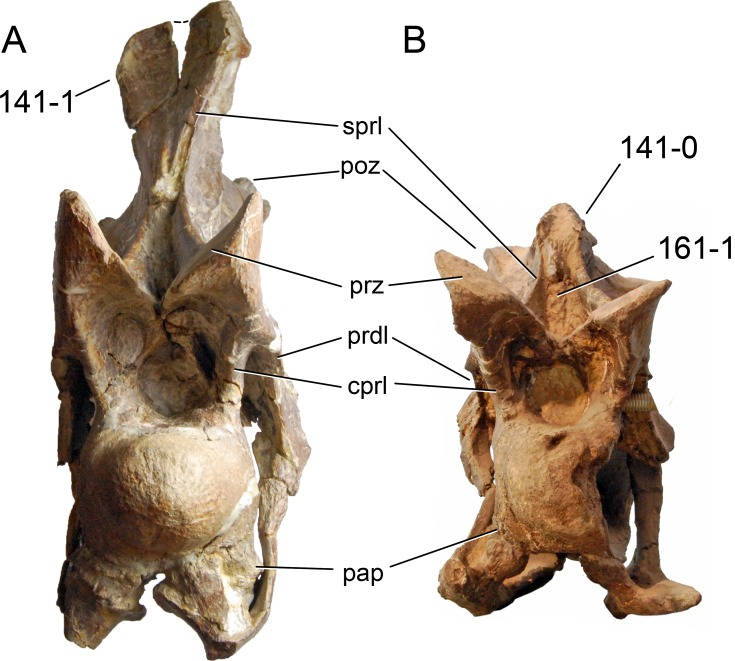
Cervical vertebra 5 of flagellicaudatans.Cervical vertebra 5 of Suuwassea emilieae ANS 21122 (A) and Kaatedocus siberi SMA 0004 (B; modified from Tschopp & Mateus, 2013b) in anterior view. Note the transversely widening (A; C141-1) instead of straight (B; C141-0) neural spine, and the presence of a prespinal lamina in Kaatedocus (B; C161-1). The neural spine of Suuwassea (A) is not bifurcated, but broken (as indicated by the dashed line). Abb.: cprl, centroprezygapophyseal lamina; pap, parapophysis; poz, postzygapophysis; prdl, prezygodiapophyseal lamina; prz, prezygapophysis; sprl, spinoprezygapophyseal lamina. Vertebrae scaled to the same anterior condyle length.